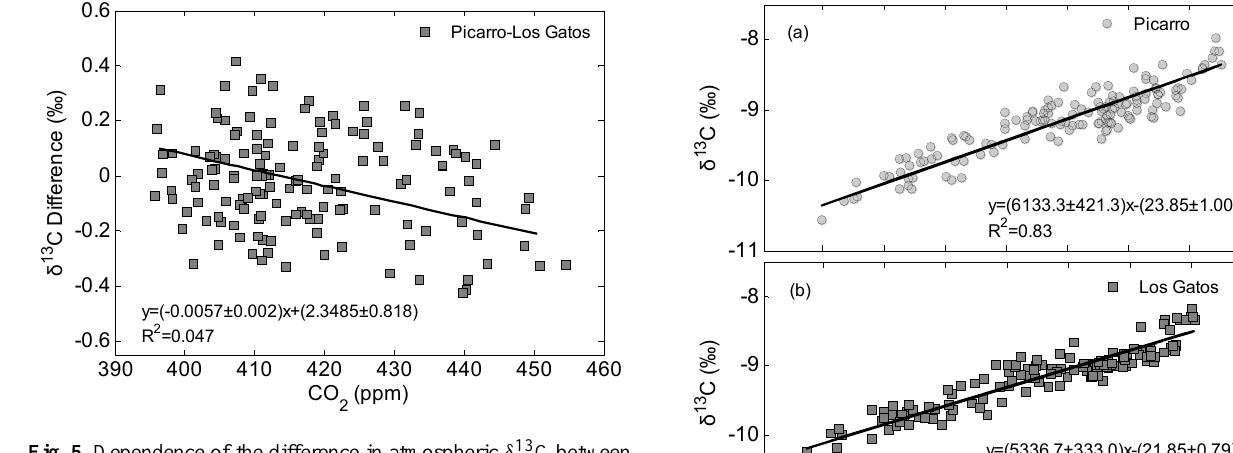
Fig. 5. Dependence of the difference in atmospheric δ 13 C between the two analyzers on the CO 2 concentration. Here Method 1 was used for calibration.